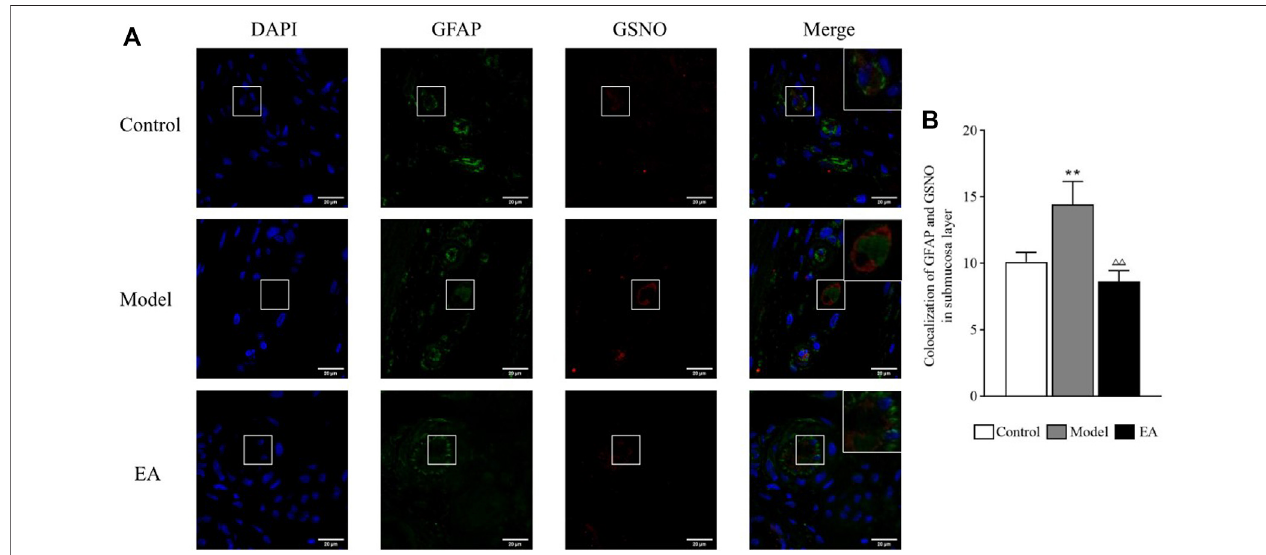
FIGURE 8 | Colocalized GFAP and GSNO expressions in the submucosal layer. GFAP and GSNO fl uorescence in different groups (A) ; green indicates GFAP, red indicates GSNO, and blue indicates DAPI-stained nucleus. One-way ANOVA indicated that the colocalization of GFAP and GSNO was signi fi cantly higher in the model groupandsigni fi cantlylowerafterEAtreatment (B) .scalebar=20 μ m,bar:mean±SE, n =4,** p < 0.01,versusthecontrolgroup; △△ p < 0.01,versusthemodelgroup.